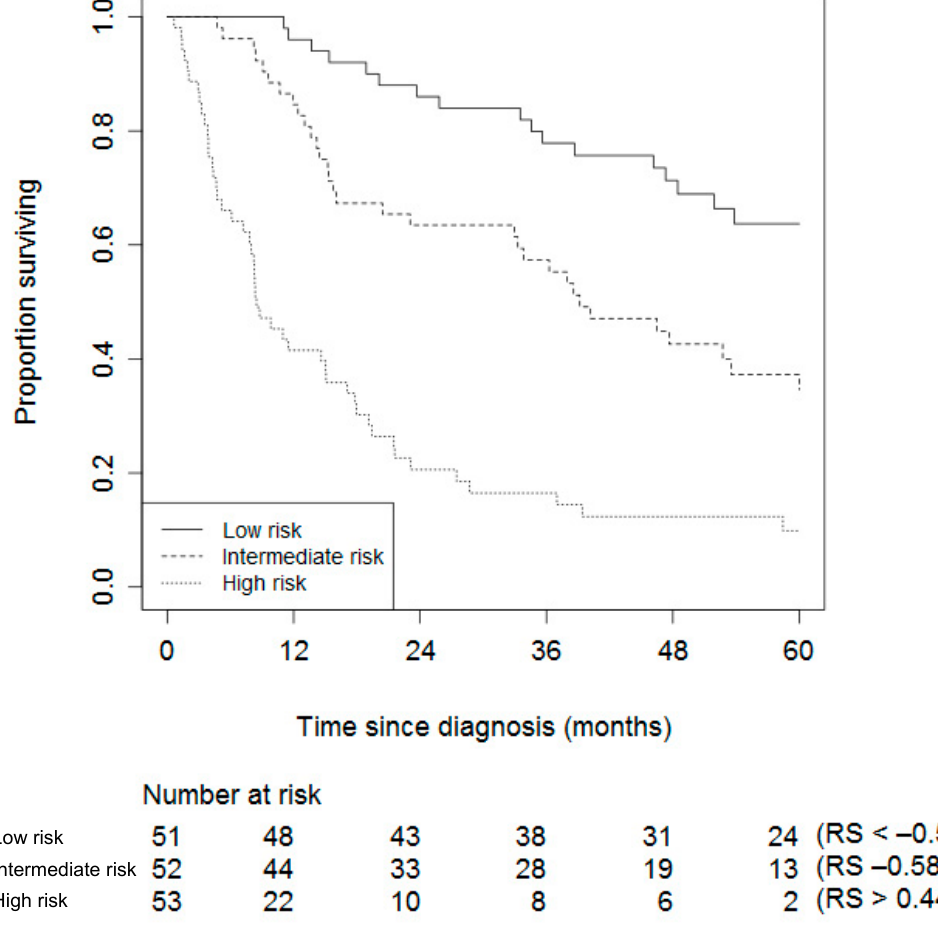
Figure 3. Kaplan–Meier stratified by risk groups based on each individual’s risk score (RS) of the model including Ki67.